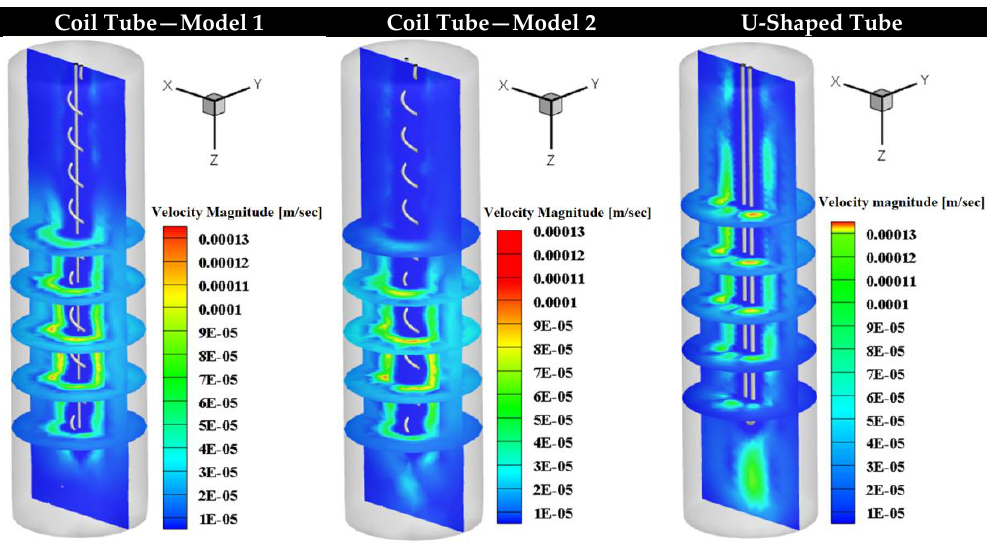
Figure 14. Three-dimensional contours of the velocity magnitude (m/s) for the three models.